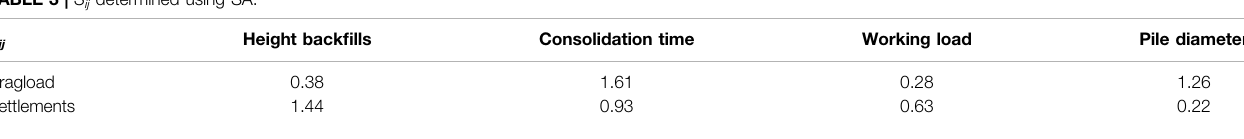
TABLE 3 | S ij determined using